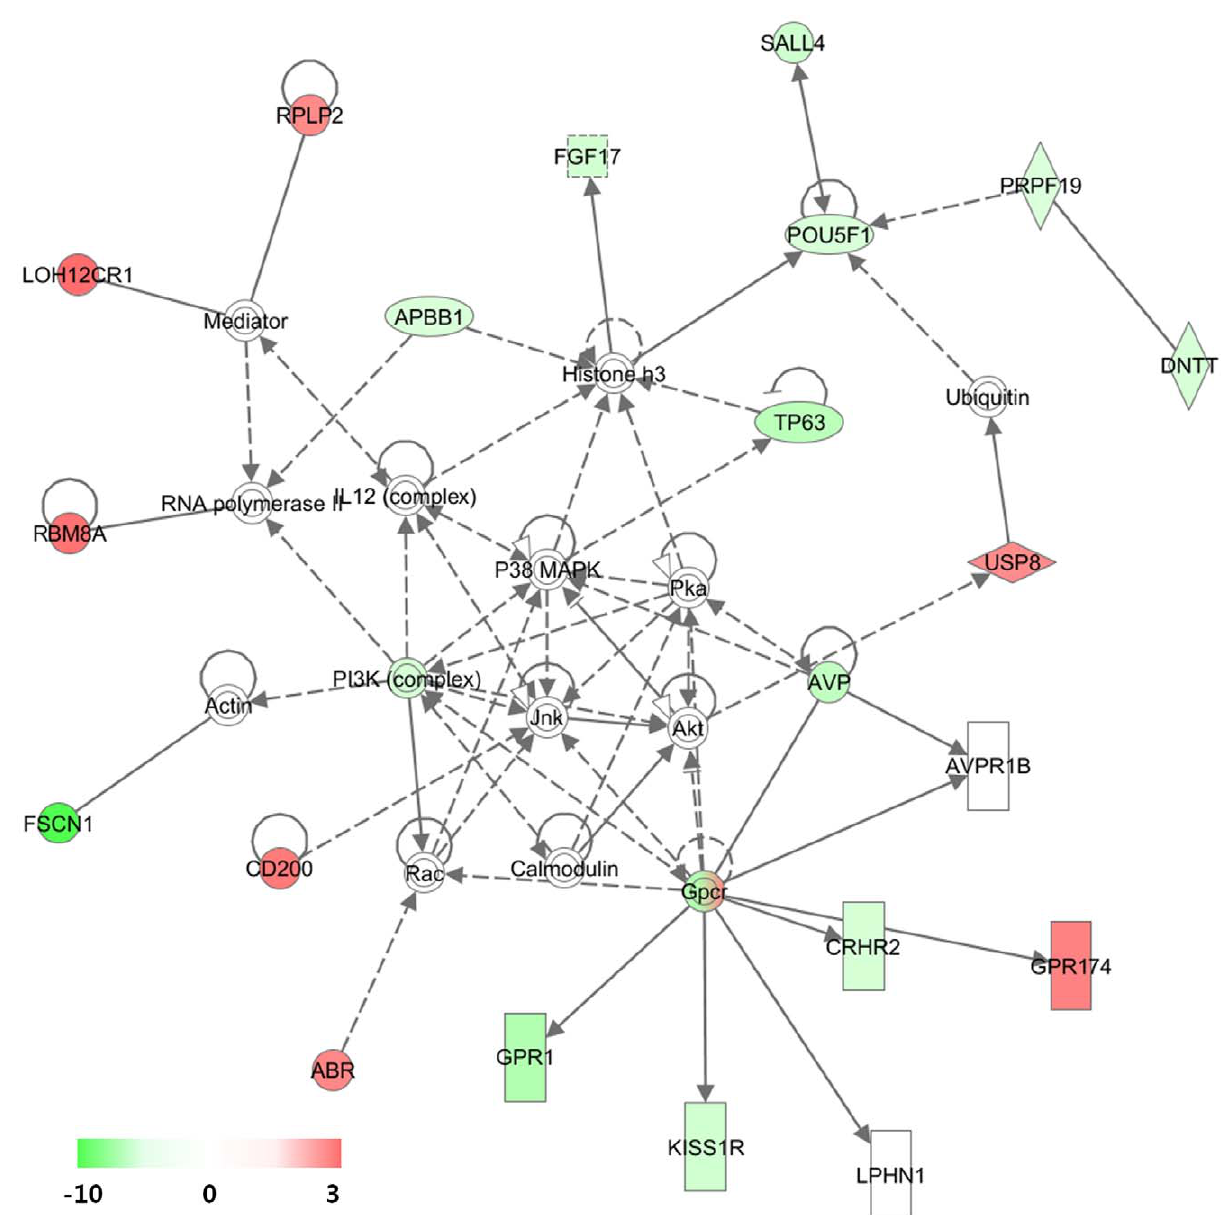
Figure 3. Highest confidence network of genes regulated by sLF. Highest confidence network of genes displaying altered expression levels in response to secreted sLF in HEK293 cells. According to IPA, the network is relevant to ‘Genetic Disorder, Hematological Disease, Metabolic Disease’. Genes that were upregulated are presented in red, whereas those that were downregulated are presented in green, where the intensity of the color reflects the magnitude of the expression change, as indicated in the scale bar. Each interaction is supported by at least one literature reference, with solid lines representing direct interactions and dashed lines representing indirect interactions.